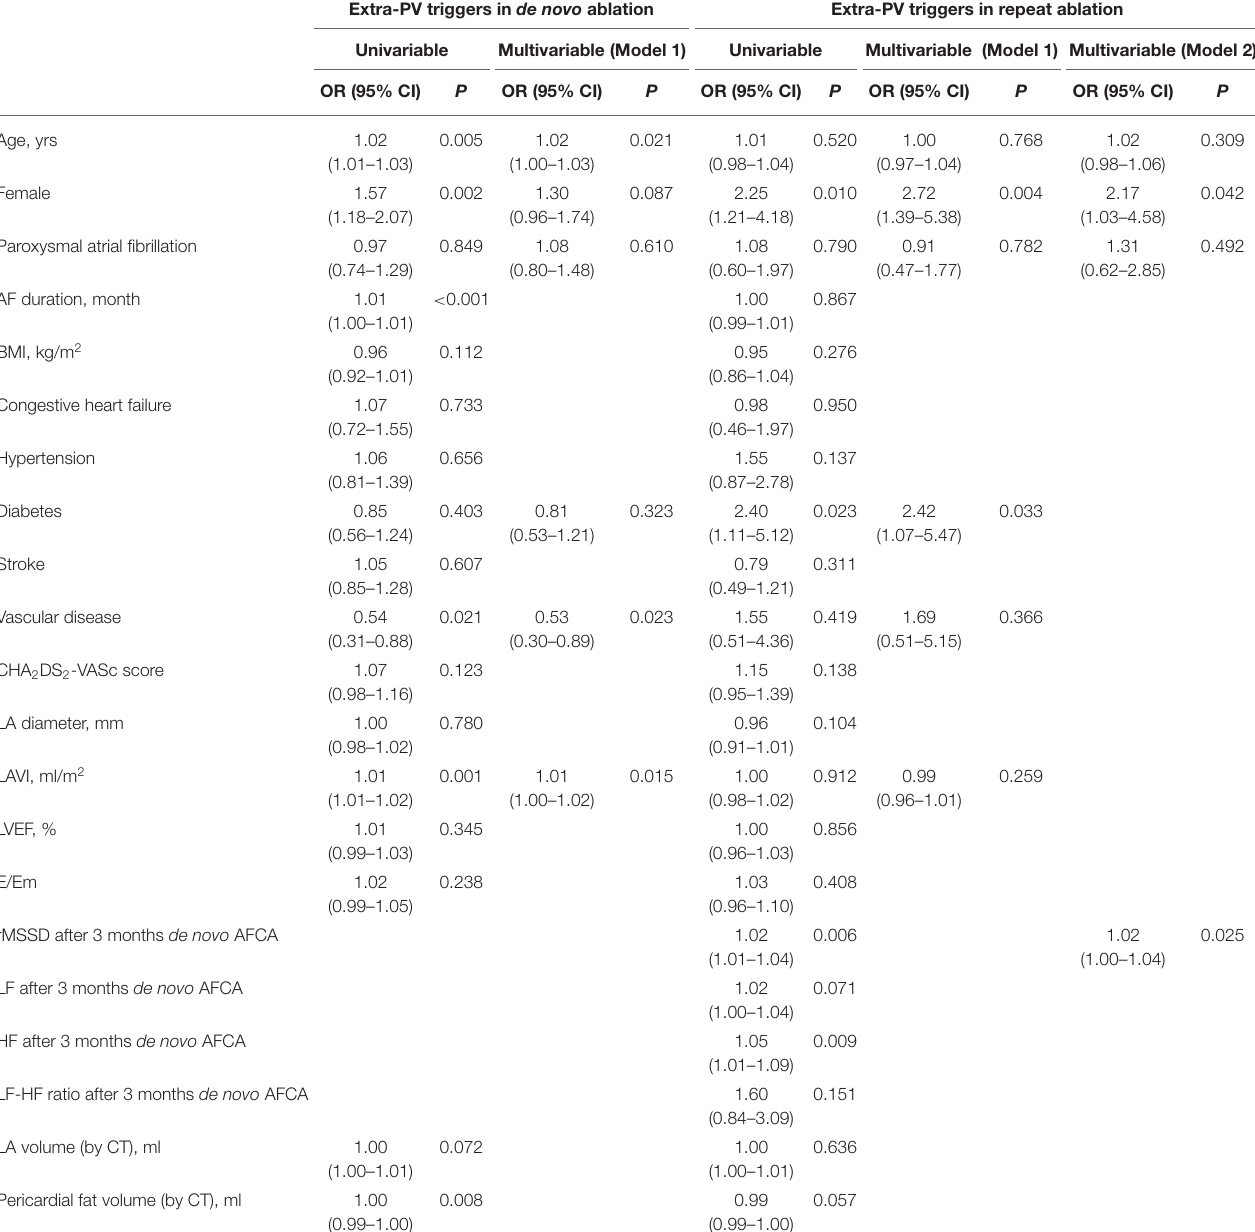
TABLE 2 | Logistic regression analysis for predictors of extra-PV triggers in the de novo and repeat